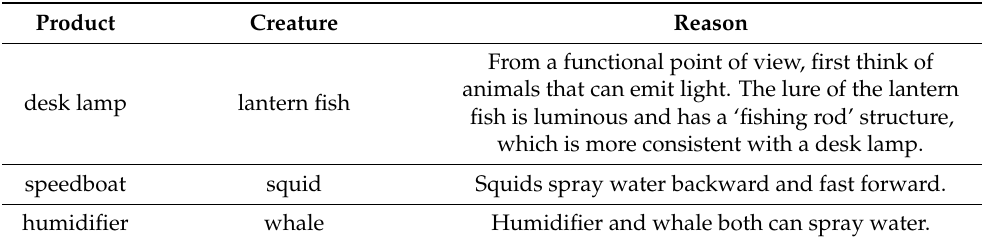
Table 3. Product function- creature function reasoning (34 times).